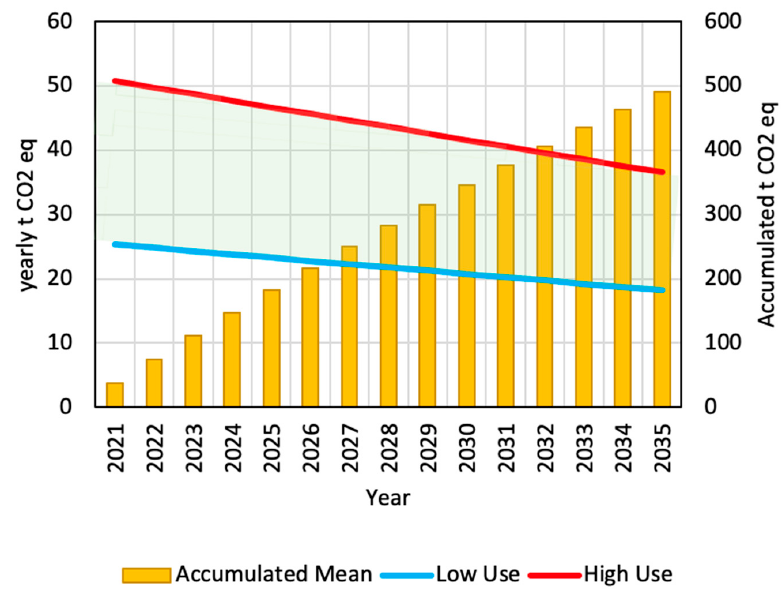
Figure 2. System’s life cycle carbon emissions reduction